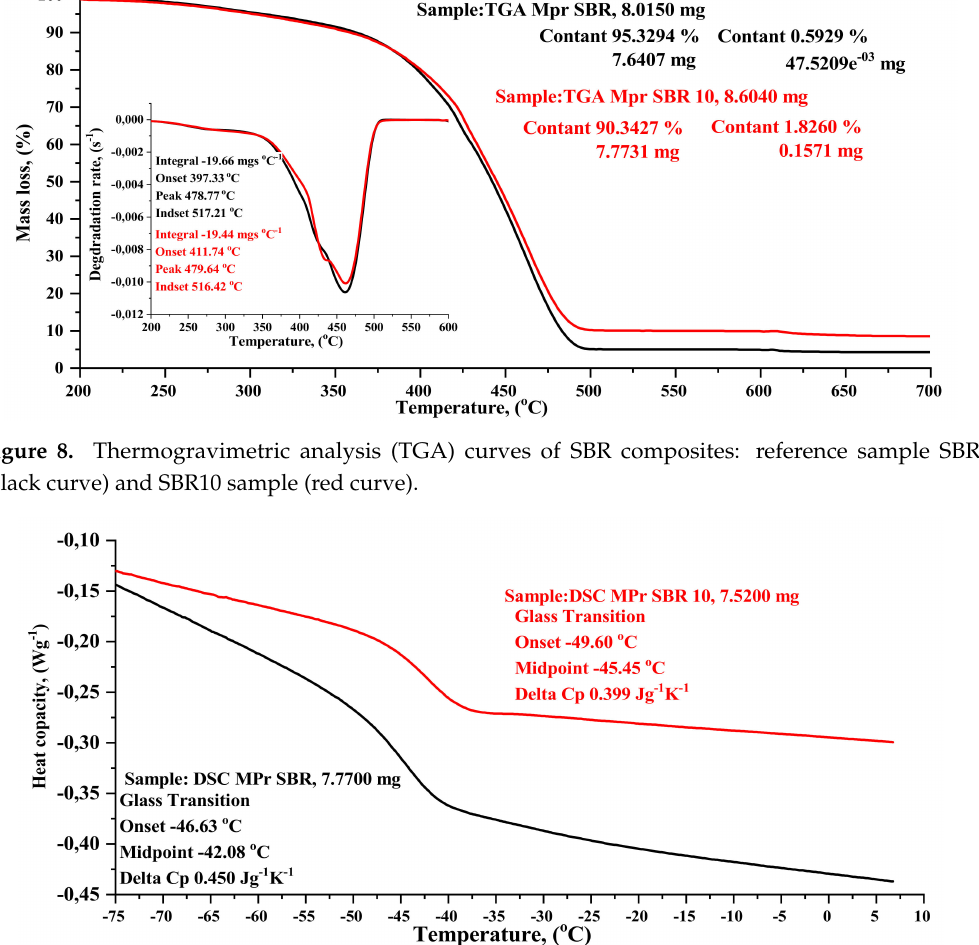
Figure 9. Comparative analysis of DSC results: SBR—unfilled (black curie) and SBR10 (10 phr of BDC—red